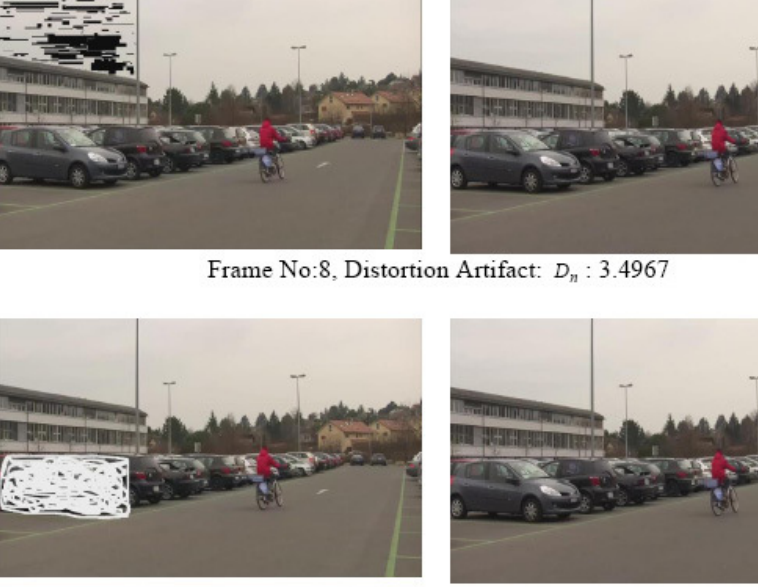
Figure 7. Different error scenarios induced in left views of 3D Video (part-2).